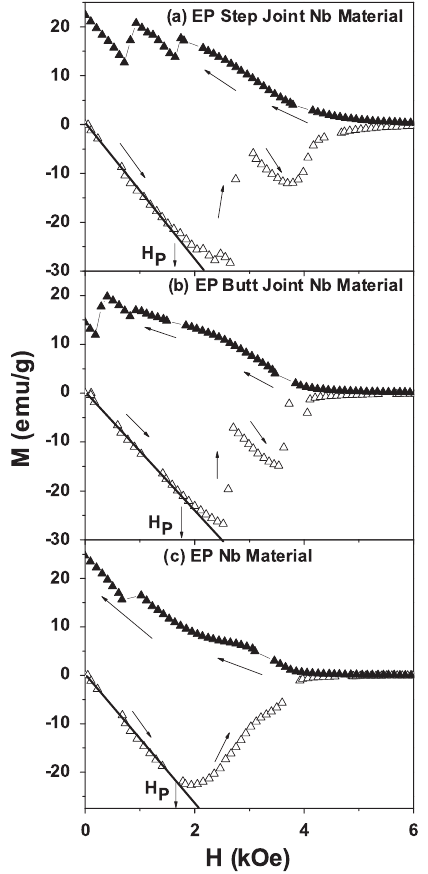
FIG. 9. Isothermal M versus H plots of (a) electron beam welded and electropolished niobium step joint (top), (b) electron beam welded and electropolished niobium butt joint (middle), and (c) electropolished as-received niobium (bottom), starting from the zero field cooled state at 2